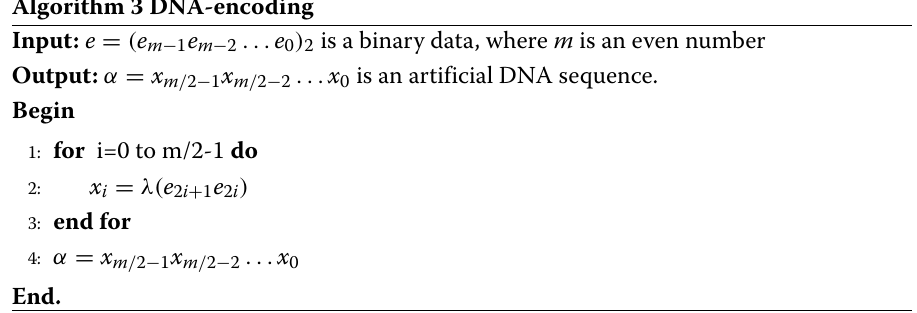
Algorithm 3 DNA-encoding